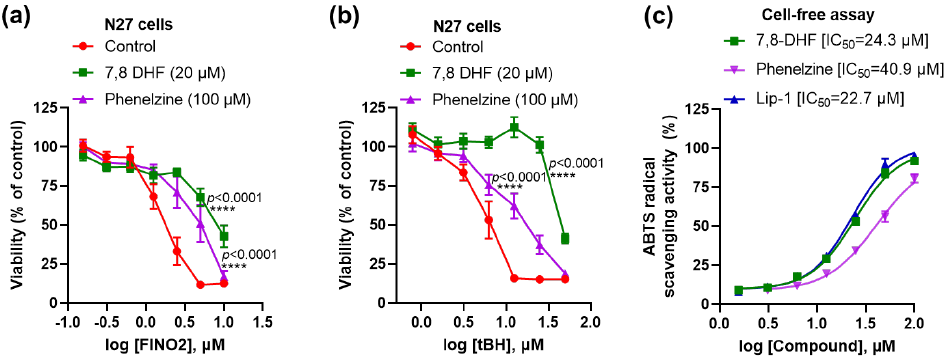
Figure 3. Both 7,8-DHF and phenelzine protect against ferroptosis and have RTA properties. Both 7,8-DHF and phenelzine attenuate FINO2- and tBH-induced toxicity ( a , b ). RTA properties of 7,8-DHF, phenelzine and Lip-1 in cell-free ABTS assay ( c ). Cells were co-treated with ferroptosis inducers and tested compounds for 24 h, except for tBH, which had a 4 h co-treatment. Cell viability assay was measured by MTT assay. Data points signify mean percentage survival relative to untreated con- trols ± SEM, n = 9–16 from 3–4 independent experiments. P values were calculated using the two-way ANOVA (Dunnett’s multiple comparisons test), and the significant level is noted as **** p < 0.0001 (vs.